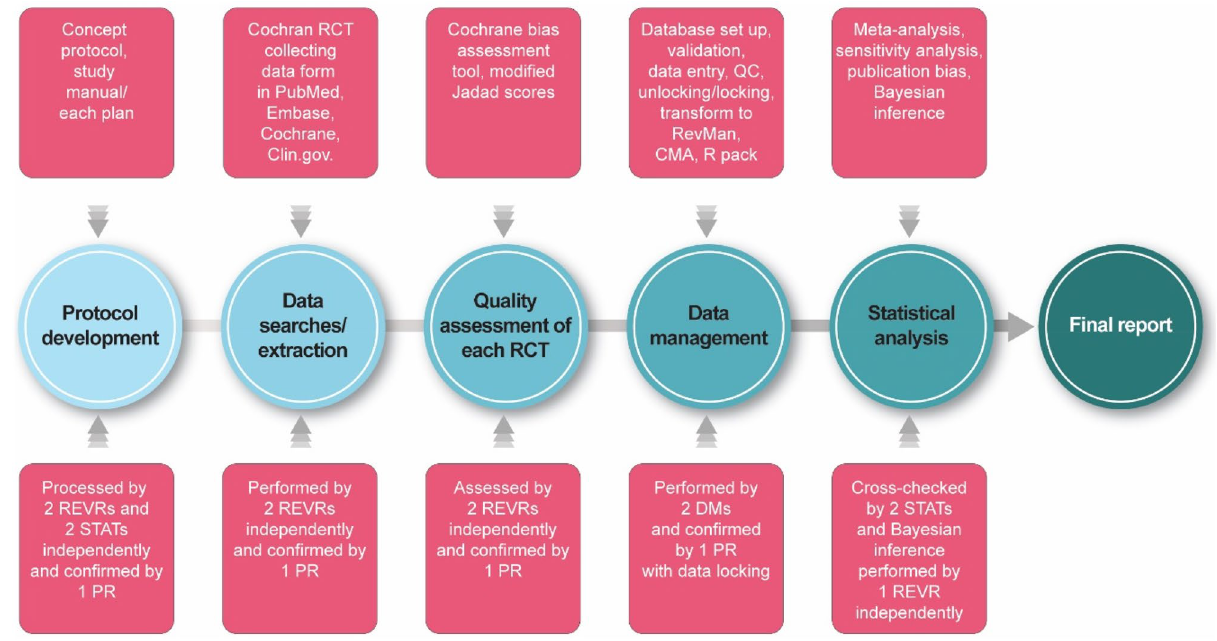
Figure 1. Study procedure using the quality management